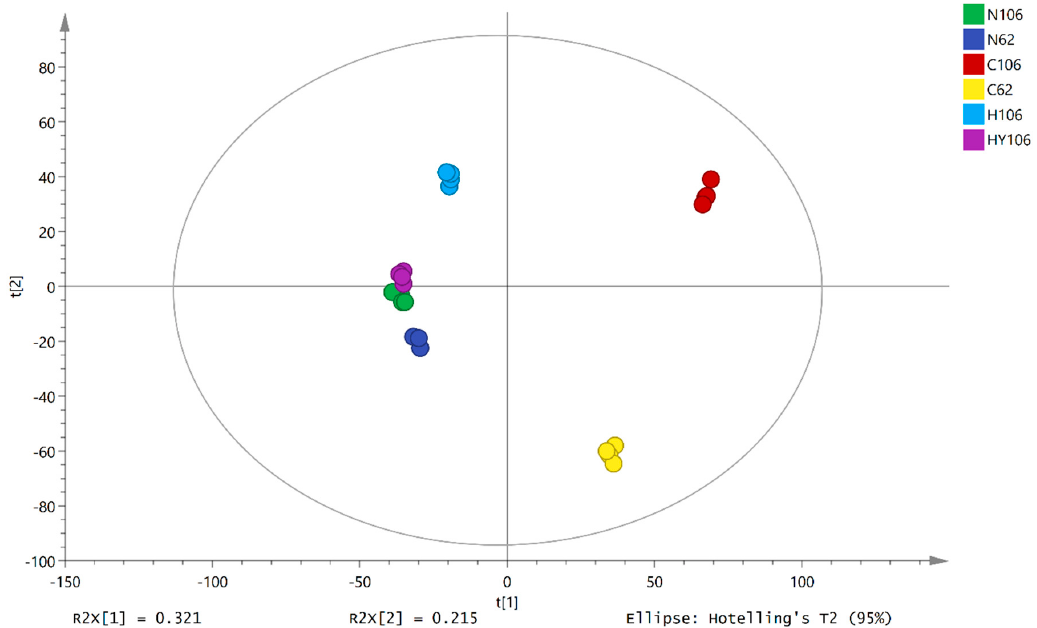
Figure 2. PCA score plots for di ff erent lettuce seed metabolomes. A five principle component-based PCA model (R 2 X (cum) = 0.774, Q 2 (cum) = 0.49) for GC / MS and UPLC-IMS-QTOF / MS data was obtained; the PCA analysis separated six di ff erent groups (N62: S13K0062 dry seeds; N106: S15K106 dry